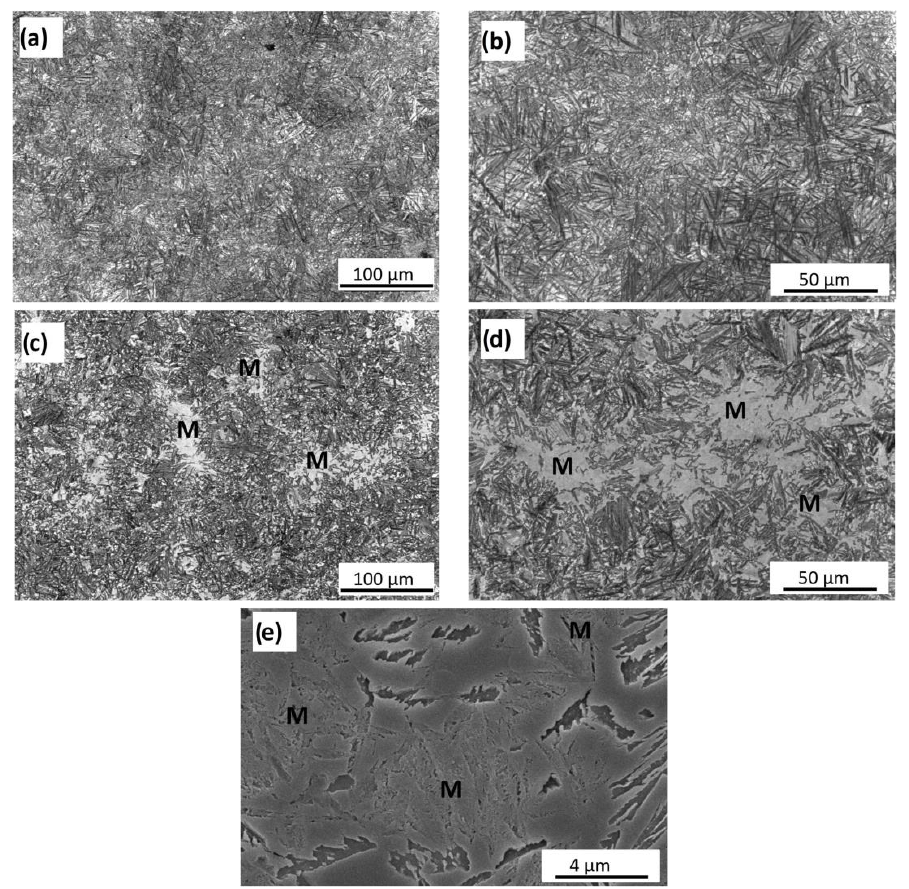
Figure 16. LOM and SEM micrographs showing the microstructure of a region near at the fracture surface of tensile samples after test, transformed at: ( a , b ) LOM-280 °C: No martensite was observed. ( c , d ) LOM-330 °C and ( e ) SEM-330 °C: Martensite can be appreciated, pointed out with M letter (lighter areas), evidencing the Transformation-Induced Plasticity (TRIP) effect. Nital 2%.